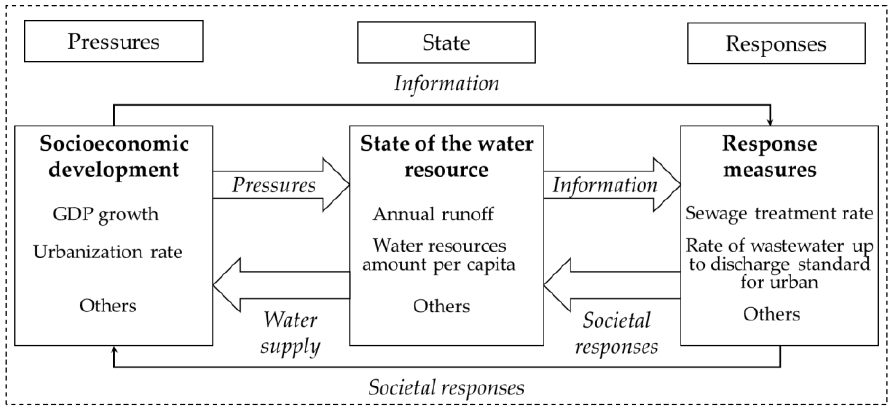
Figure 1. PSR Framework.